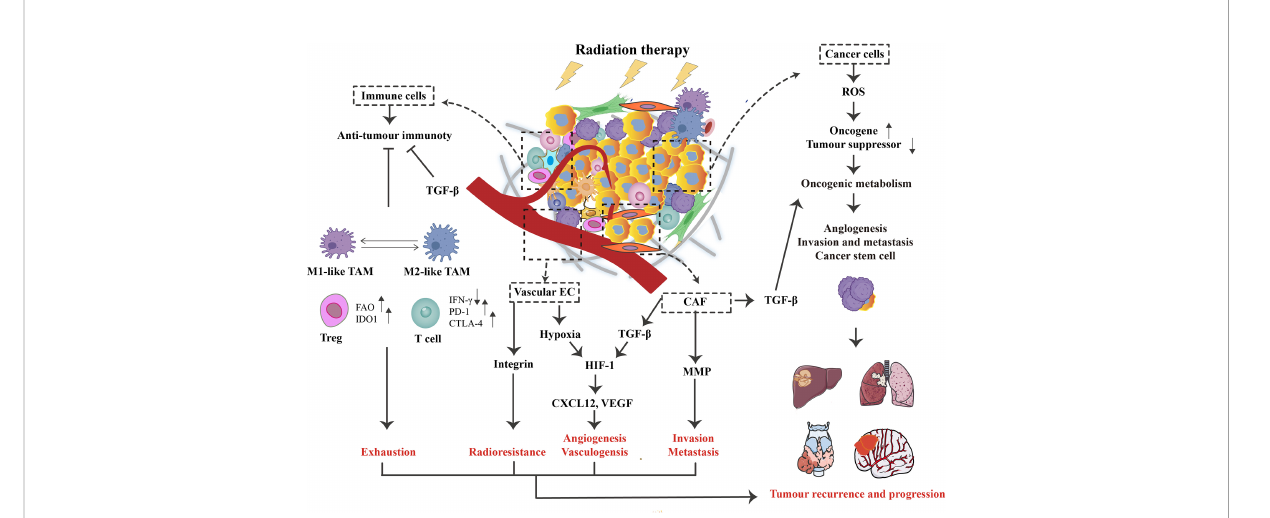
FIGURE 1 The role of radiotherapy(RT) on the tumor microenvironment (TME). Concerning cancer cells, RT can promote the generation of reactive oxygen species (ROS), causing activated oncogenes and inactivated tumor suppressors. This process supports oncogenic metabolism, increases tumor aggressiveness, and ultimately leads to recurrence and distant metastasis. In addition, RT triggers various changes in TME, such as hypoxia and immune responses. For intense, TGF- b can in fl uence cancer cells and CAFs, enhancing tumor immune escape and associated activation of HIF-1 signaling. At the same time, vascular endothelial cells (ECs) are damaged, contributing to hypoxia and promoting the HIF-1 signaling, further stimulating the expression of vascular endothelial growth factor (VEGF) and CXCL12. Although RT activates anti-tumor immune responses, this signaling is often inhibited by tumor escape mechanisms such as TAM, Treg, and the PD-1/PD-L1 signaling pathway, which is relatively low radiosensitive compared to other lymphocyte subpopulations. Ultimately, these RT-induced changes in TME may contribute to the poor therapeutic effect of RT on patients by facilitating exhaustion, angiogenesis, invasion, and